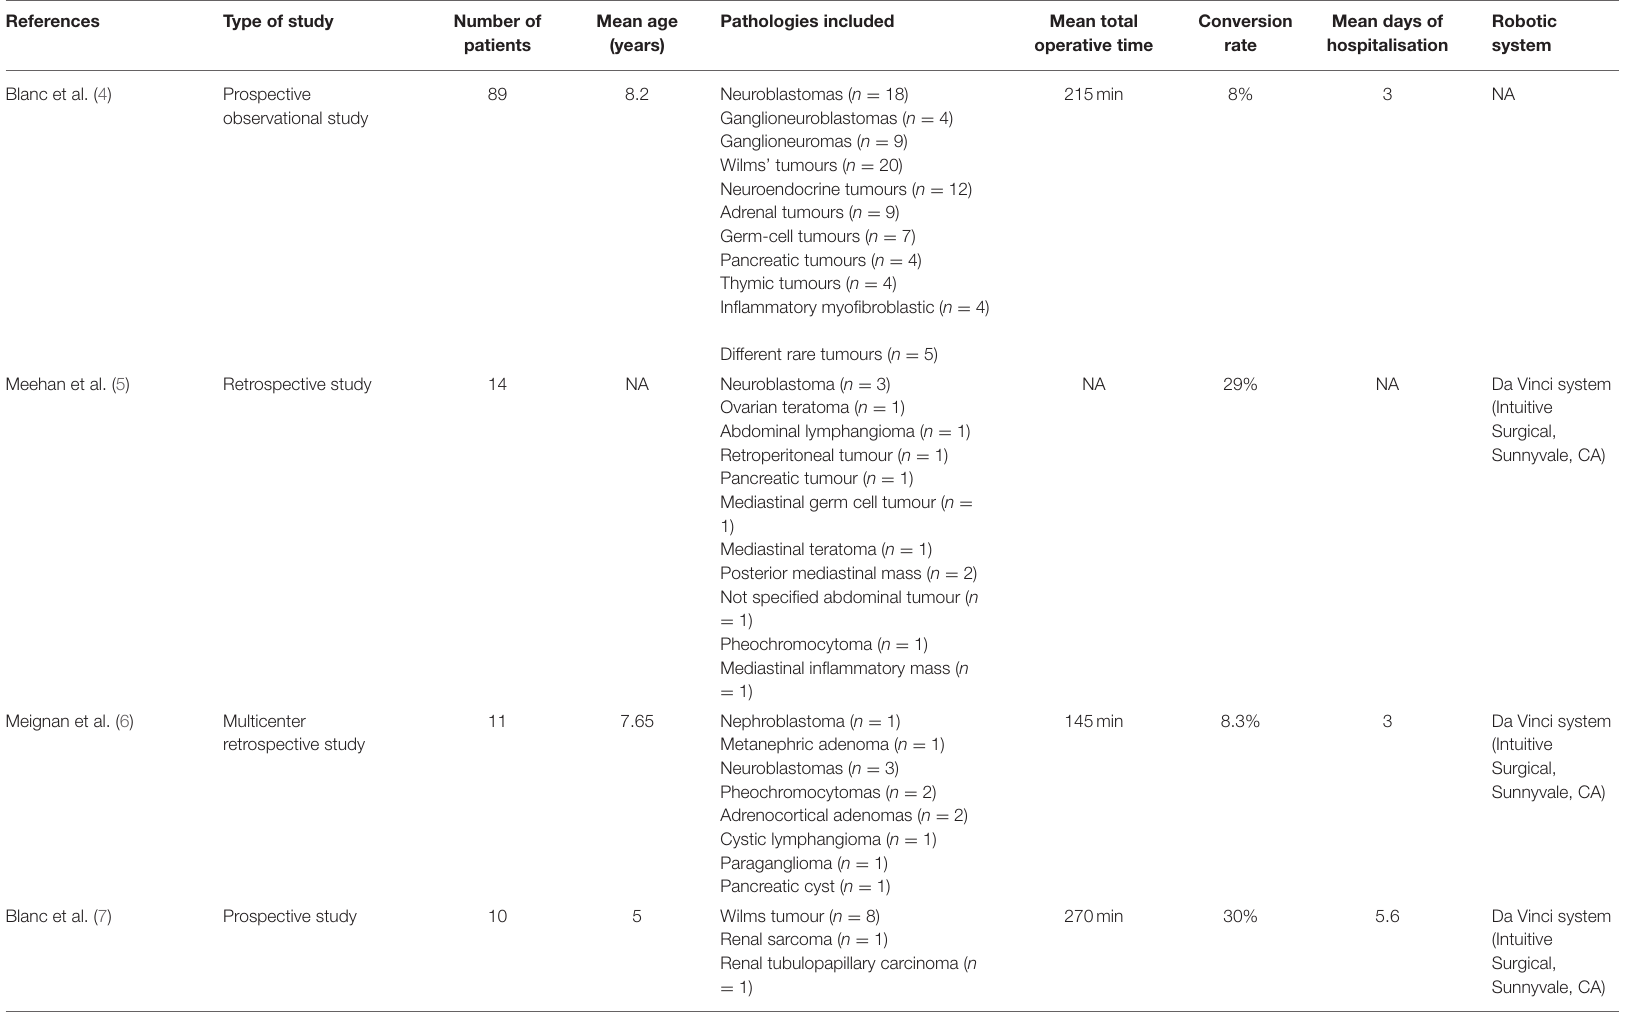
TABLE 1 | Current literature focusing on robotic surgery used for paediatric oncology